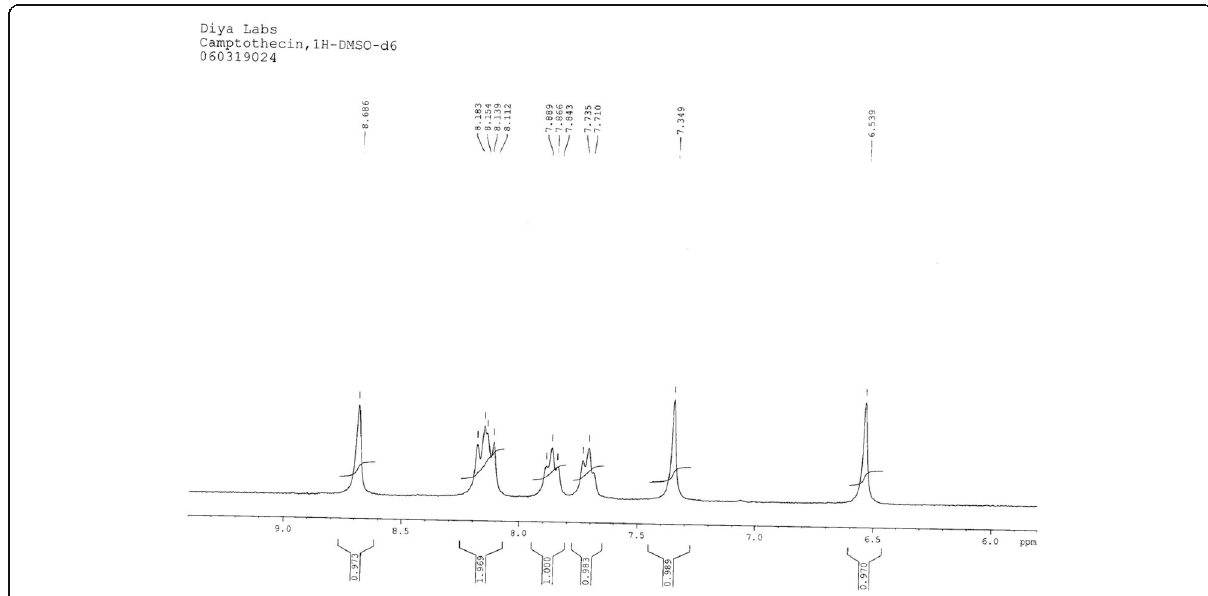
Fig. 3 NMR spectra o f camptothecin